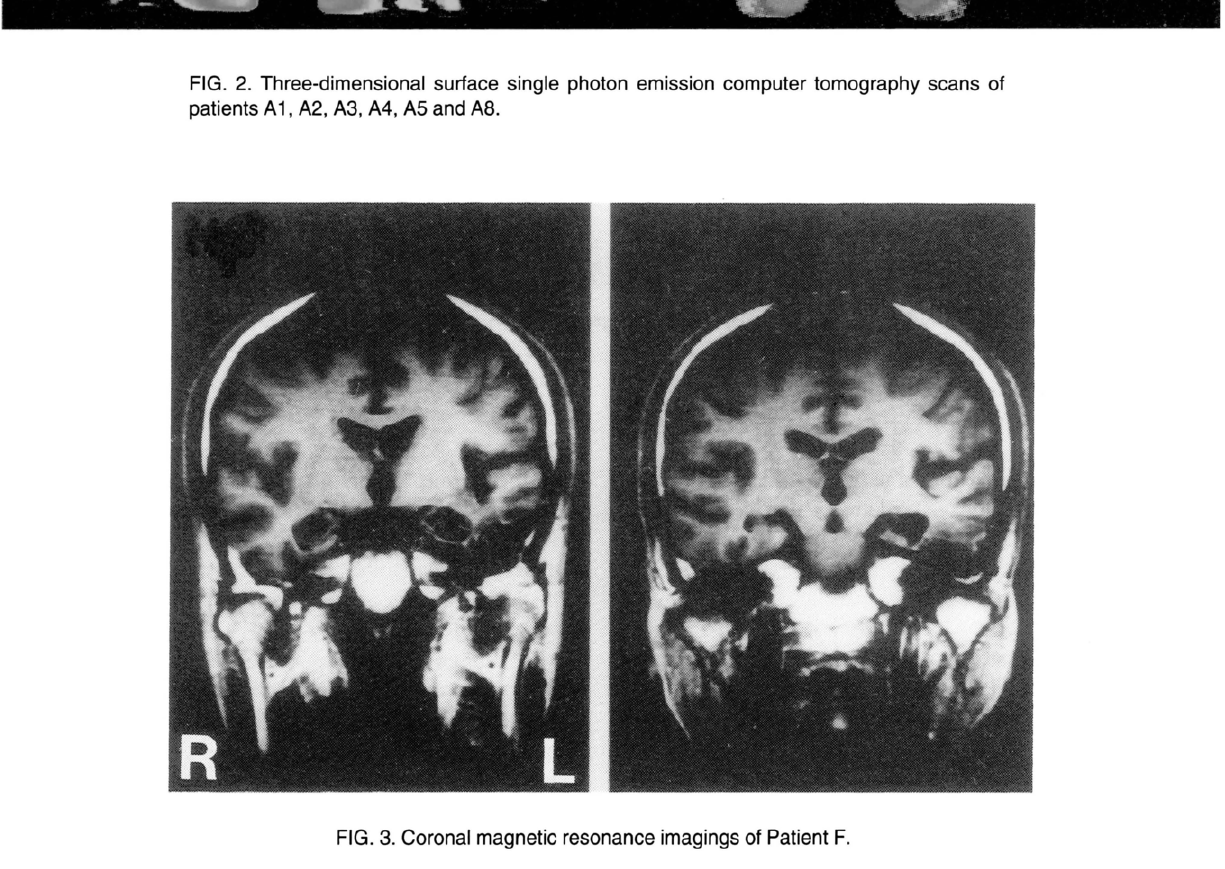
FIG. 3. Coronal magnetic resonance imagings of Patient